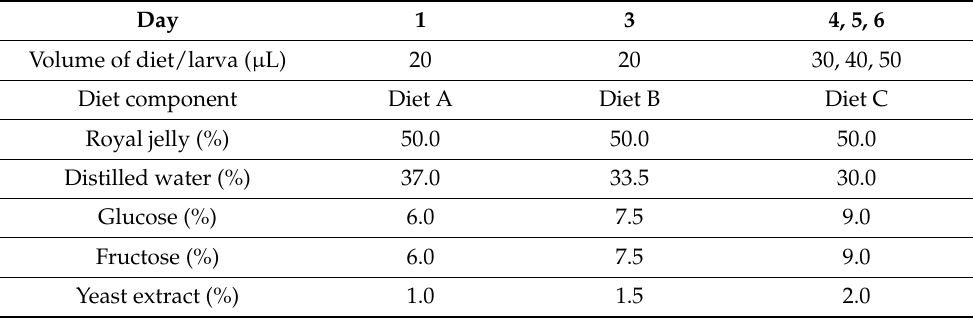
Table 1. The volume and larval diet component percentages, according to the OECD guidelines [30,31].